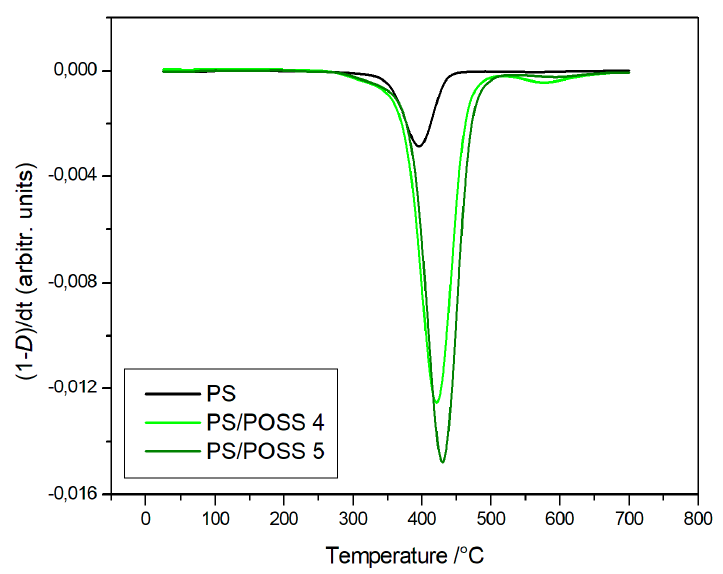
Figure 9. Di ff erential thermogravimetric curves, in an inert atmosphere, for PS and samples 4 and 5 .